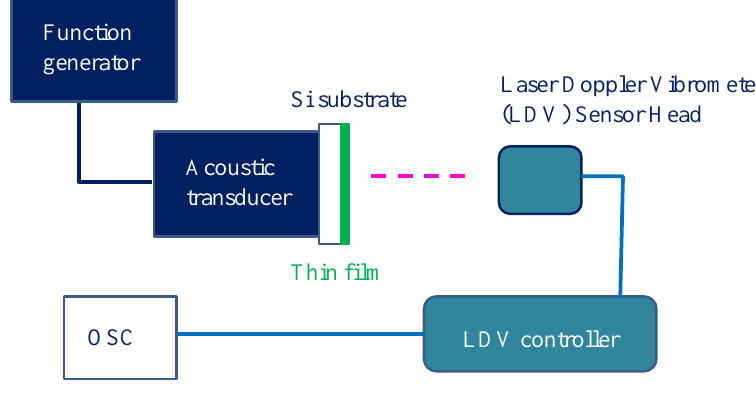
Figure 4. Doppler vibrometry